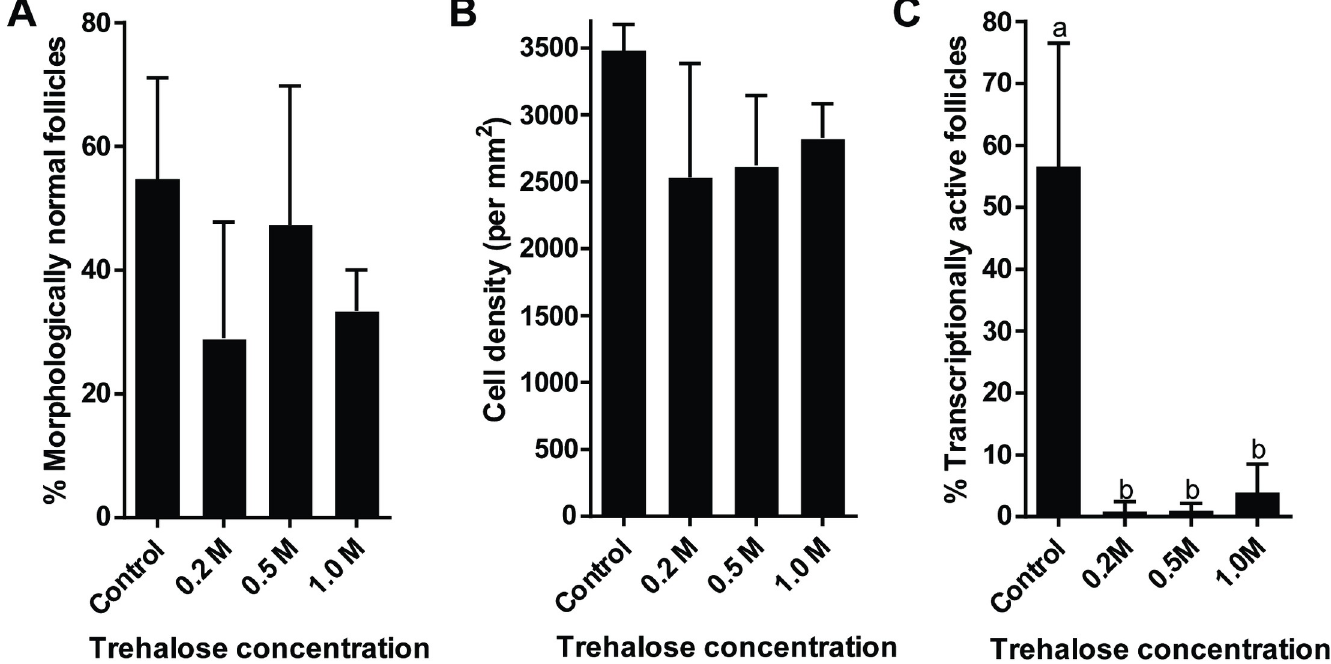
Fig 8. Effect of different trehalose concentrations on (A) follicular morphology, (B) stromal cell density, and (C) transcriptional activity after 1d storage at 4˚C. Values are mean ± SD. Values with different letters differ ( P < 0.05). No statistically significant ( P > 0.05) differences were observed in analyses for follicular morphology and cell